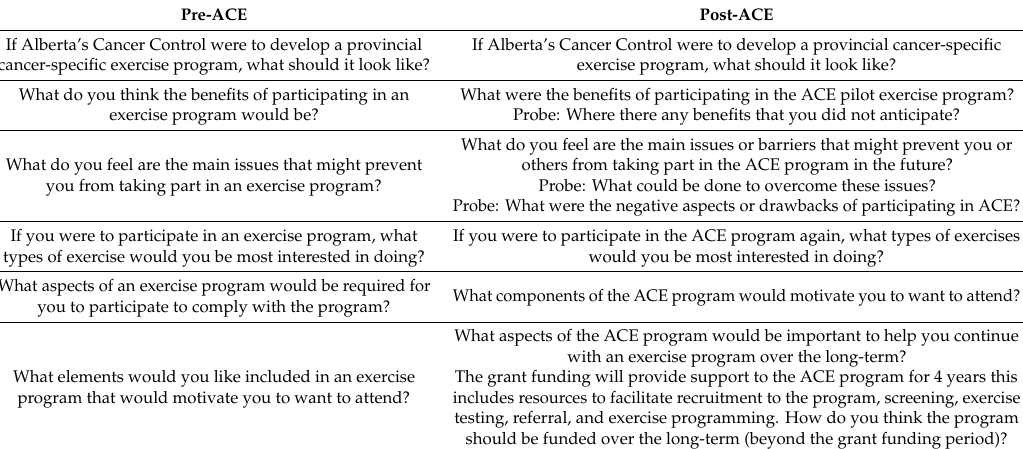
Table A1. Semi-structured Stakeholder Engagement Group Question